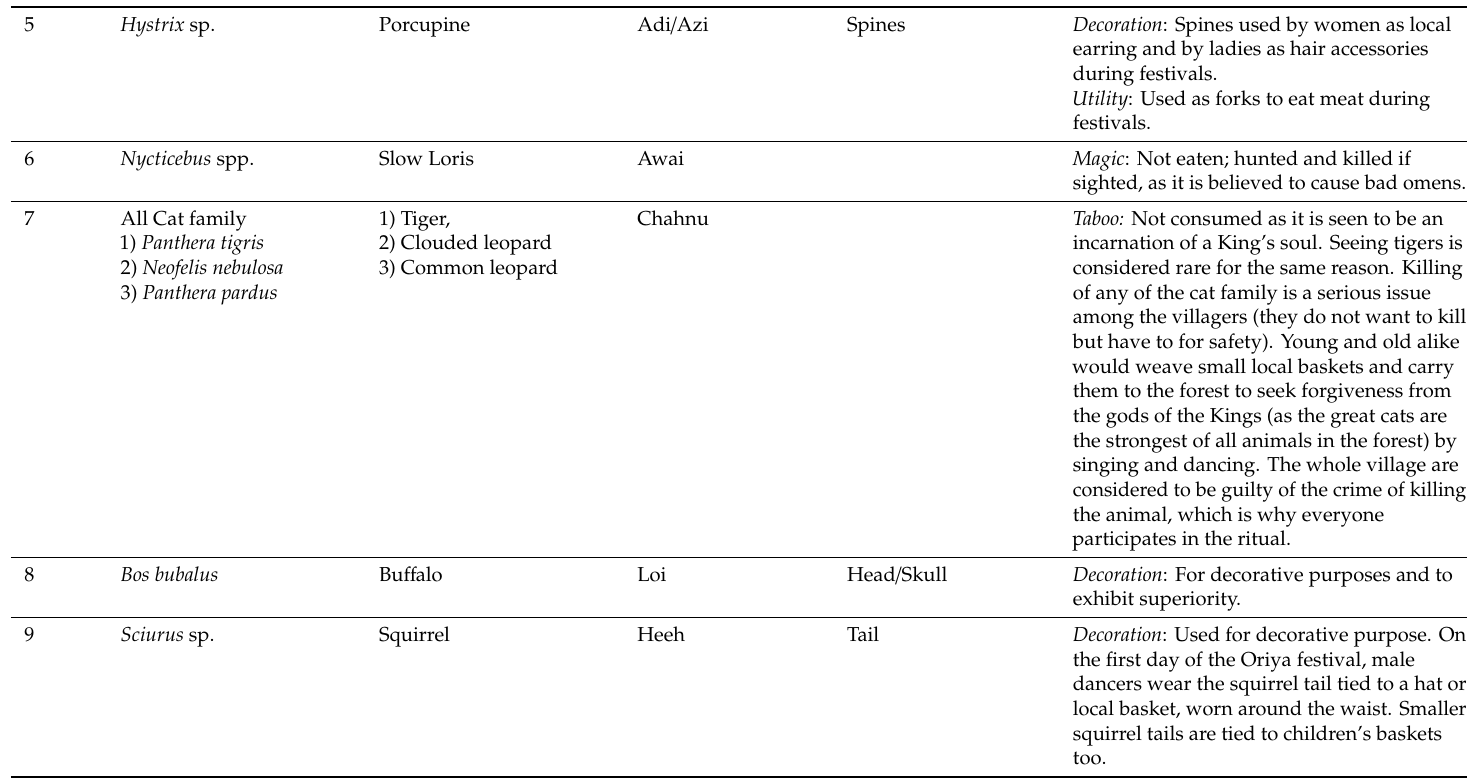
Adi / Azi Spines Decoration : Spines used by women as local